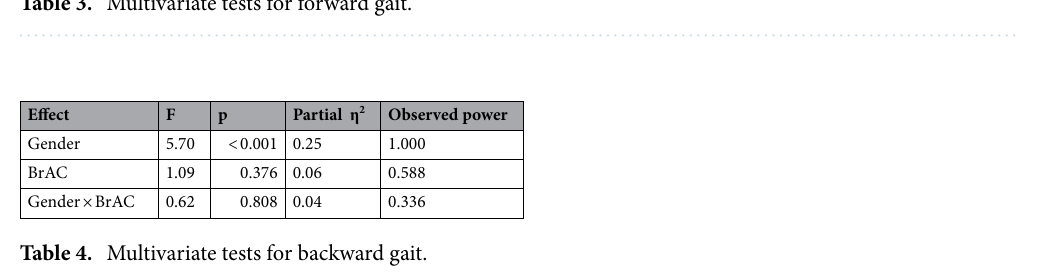
Table 3. Multivariate tests for forward gait.